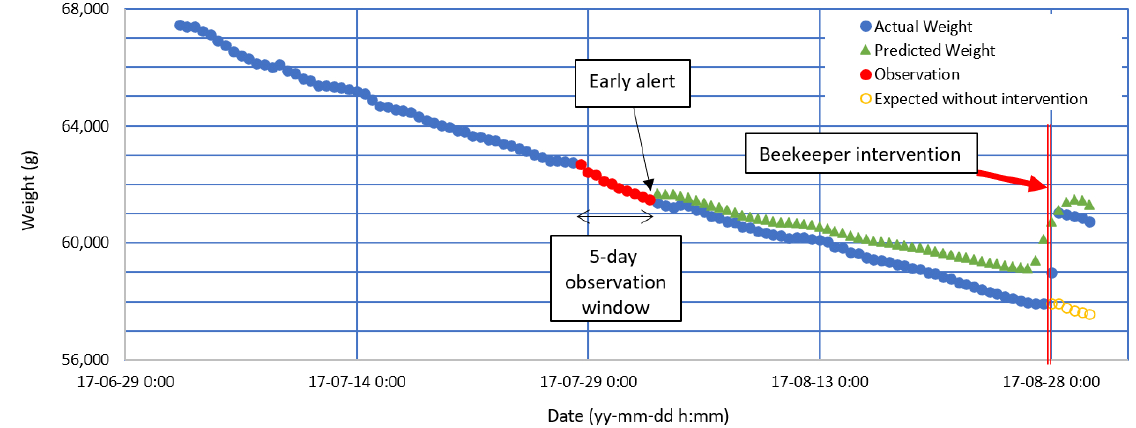
Figure 9. Two months analysis showing significant weight change triggering the beekeeper intervention to provide nour- ishment in early fall season, with both real and AI-predicted data. nourishment in early fall season, with both real and AI-predicted